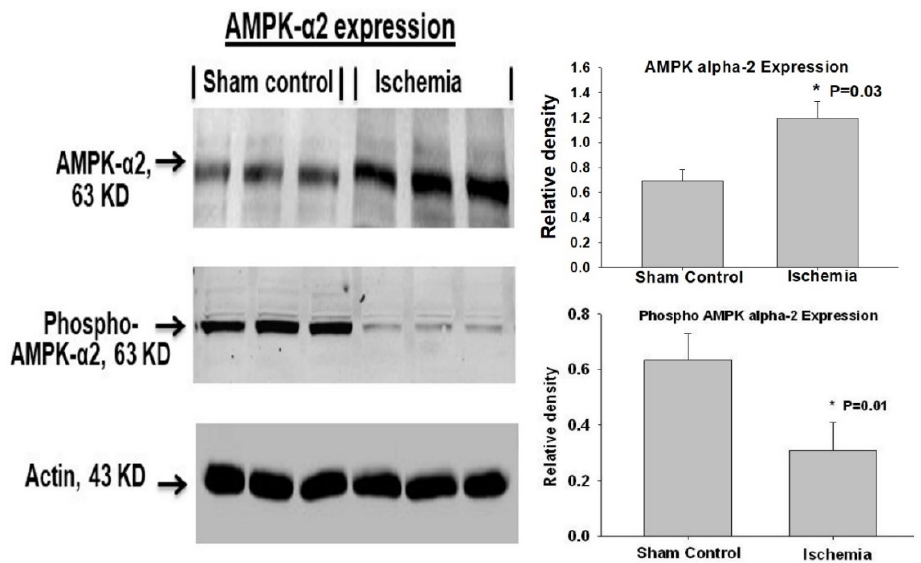
Figure 3. Western blotting of AMPK- α 2 protein showing upregulation of total AMPK- α 2 and downregulation of phosphorylated AMPK- α 2 in bladder ischemia. These observations suggest that upregulated AMPK- α 2 cannot be phosphorylated and remains inactive under ischemic conditions. * Represents significant changes in ischemia versus controls. This figure is taken from our previous publication [41].